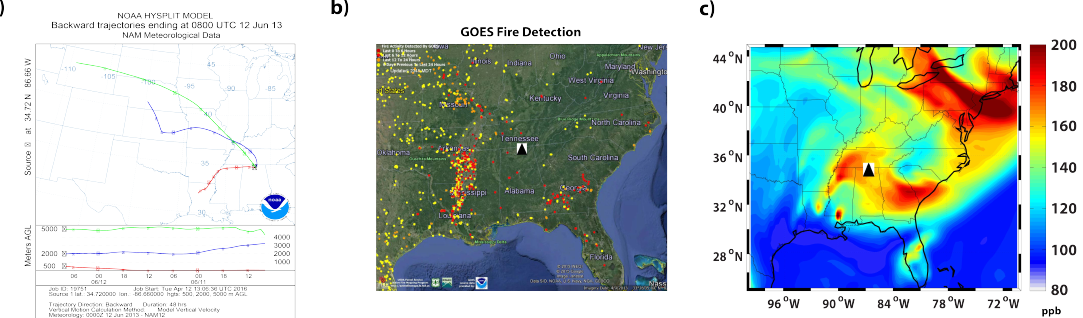
Figure 7. Information supporting the influence of wildfire emissions from ( a ) HYSPLIT back-trajectories initiated at 08 UTC (starting heights of 500 (red), 2000 (blue), and 5000 (green) m above ground level); ( b ) GOES fire detection data (red, yellow, and orange dots indicate fire activity observed in last 0–6, 6–12, 12–24 h, respectively); and ( c ) CO mixing ratios (<2 km) predicted by GEOS-Chem between 00 and 08